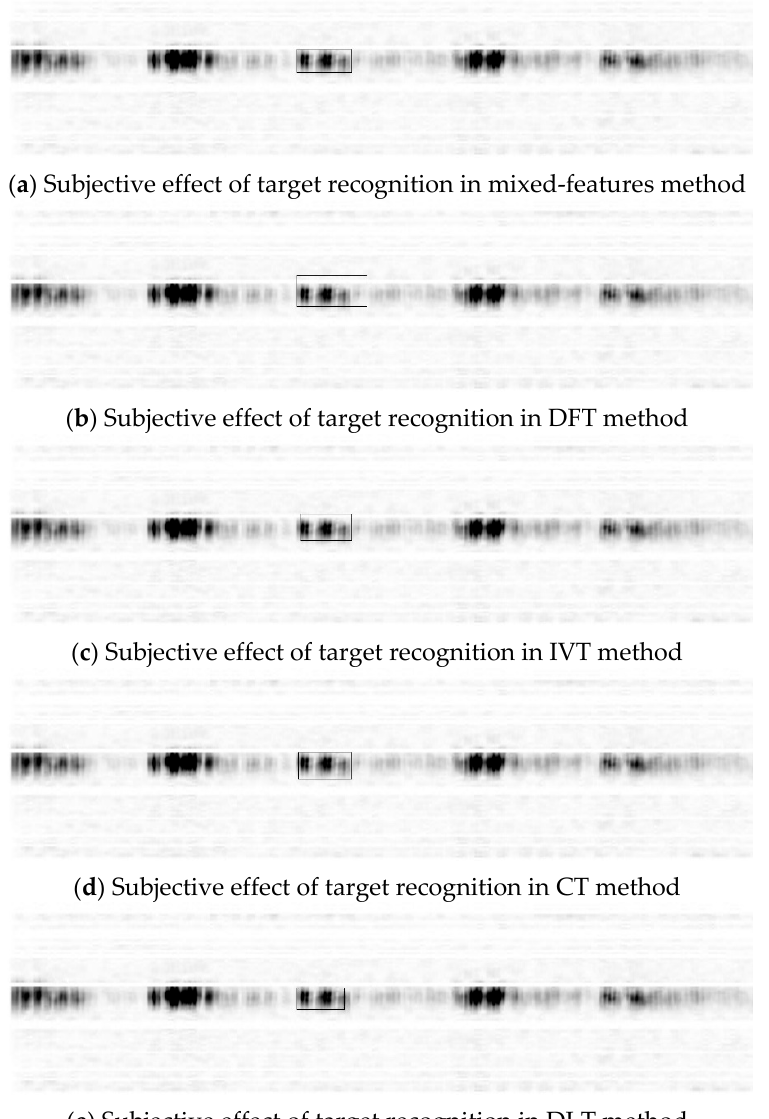
Figure 11. Subjective effect of target recognition in different methods.